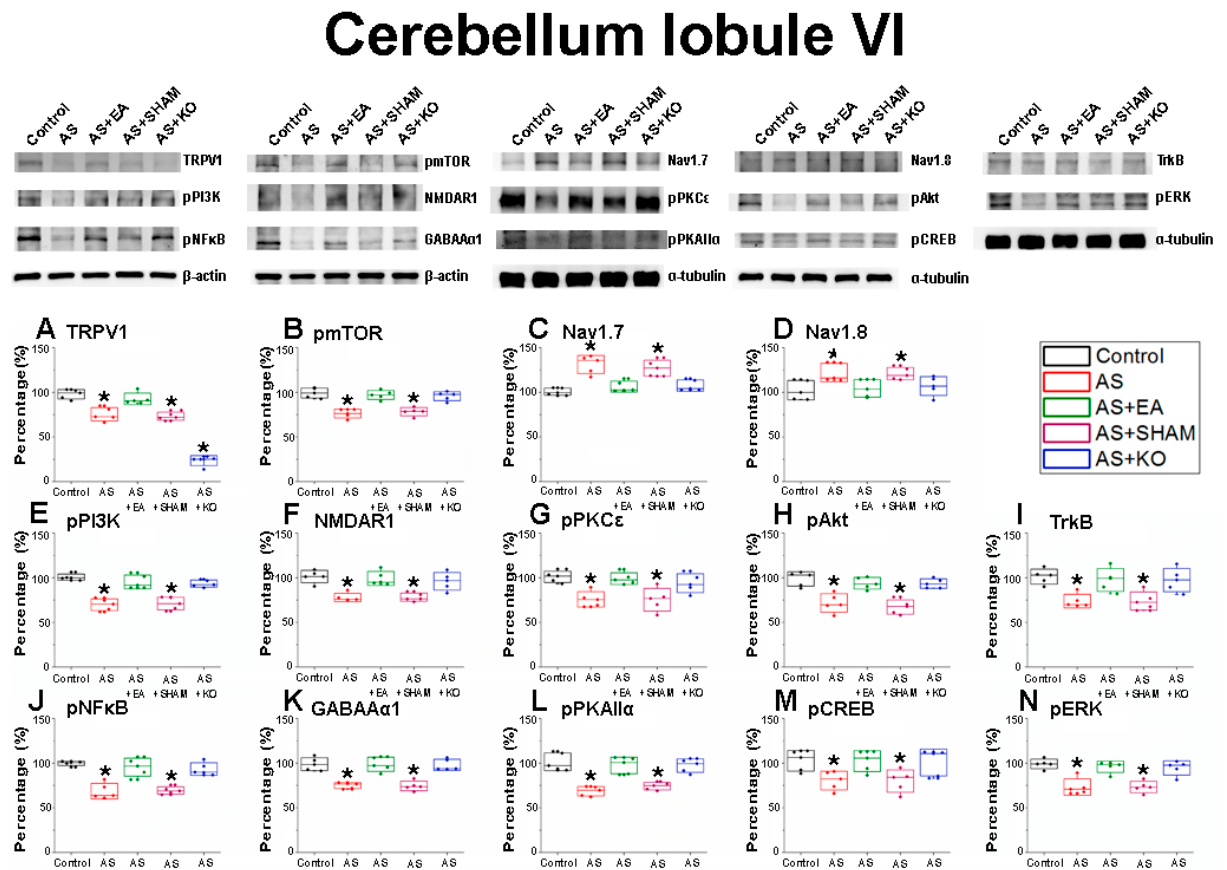
Figure 2. The expression levels of nociceptive receptors and associated molecules in cerebellum lobule VI. The immunoblotting images depict five lanes of protein in the following order: Control, AS, AS + EA, AS + SHAM, and AS + KO groups. There are significant decreases in protein expression in the AS and AS + SHAM groups of ( A ) TRPV1, ( B ) pmTOR, ( E ) pPI3K, ( F ) NMDAR1, ( G ) pPKC ε , ( H ) pAkt, ( I ) TrkB, ( J ) pNF κ B, ( K ) GABAA α 1, ( L ) pPKAII α , ( M ) pCREB, and ( N ) pERK levels, which were significantly attenuated in the AS + EA and AS + KO groups, depicting no difference when compared to the Control group. Conversely, the protein expressions of the AS and AS + SHAM groups were significantly increased in ( C ) Nav1.7 and ( D ) Nav1.8 when compared to the Control group. Correspondingly, the AS + EA and AS + KO groups were augmented and showed no significant difference in comparison to the Control group. Accordingly, the protein density of the AS + KO group revealed a predicted decrease in ( A ) TRPV1 (* p <